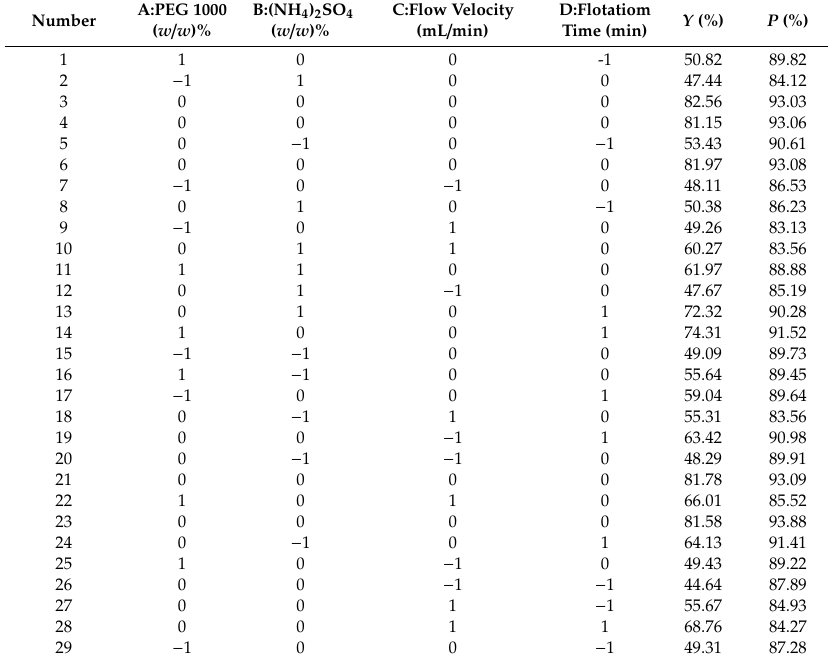
Table 2. Box-Behnken (BBD) and the results (means of triplicate tests) for the recovery yield and purification factor of ovalbumin (OVA).